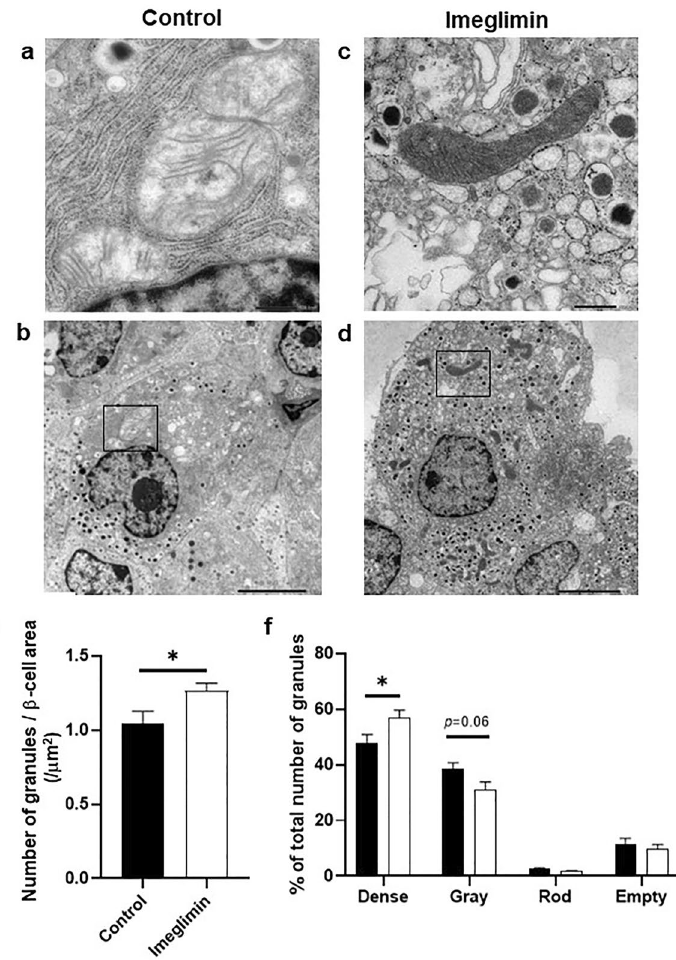
Figure 3. Effects of chronic administration of imeglimin on mitochondrial morphology and the number of insulin granules in β-cells in type 2 diabetic db/db and KK-Ay mice. ( a – d ) The mitochondria in β-cells in db/ db mice appeared to be swollen and crista structure inside mitochondria was disrupted, which was not observed in db/db mice treated with imeglimin. In addition, the number of insulin granules was preserved in db/db mice treated with imeglimin compared to that without the treatment. ( e ) Quantitative evaluation of the number of insulin granules in β-cells in db/db mice after 4-week treatment with imeglimin. The number of insulin granules in β-cells was significantly higher in the mice treated with imeglimin compared to that without the treatment. ( f ) Quantitative evaluation of insulin secretory granules according to the core; dense, gray, rod-shaped, or